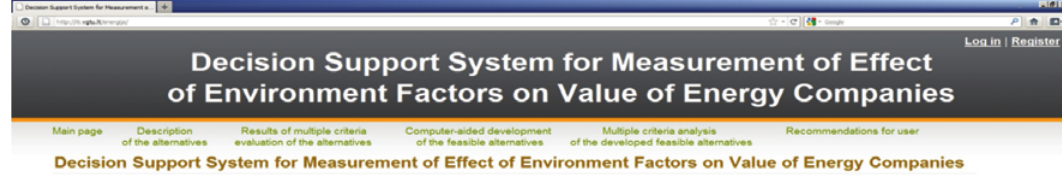
Figure 3. the opening screen of the decision support system egtaV-SPS